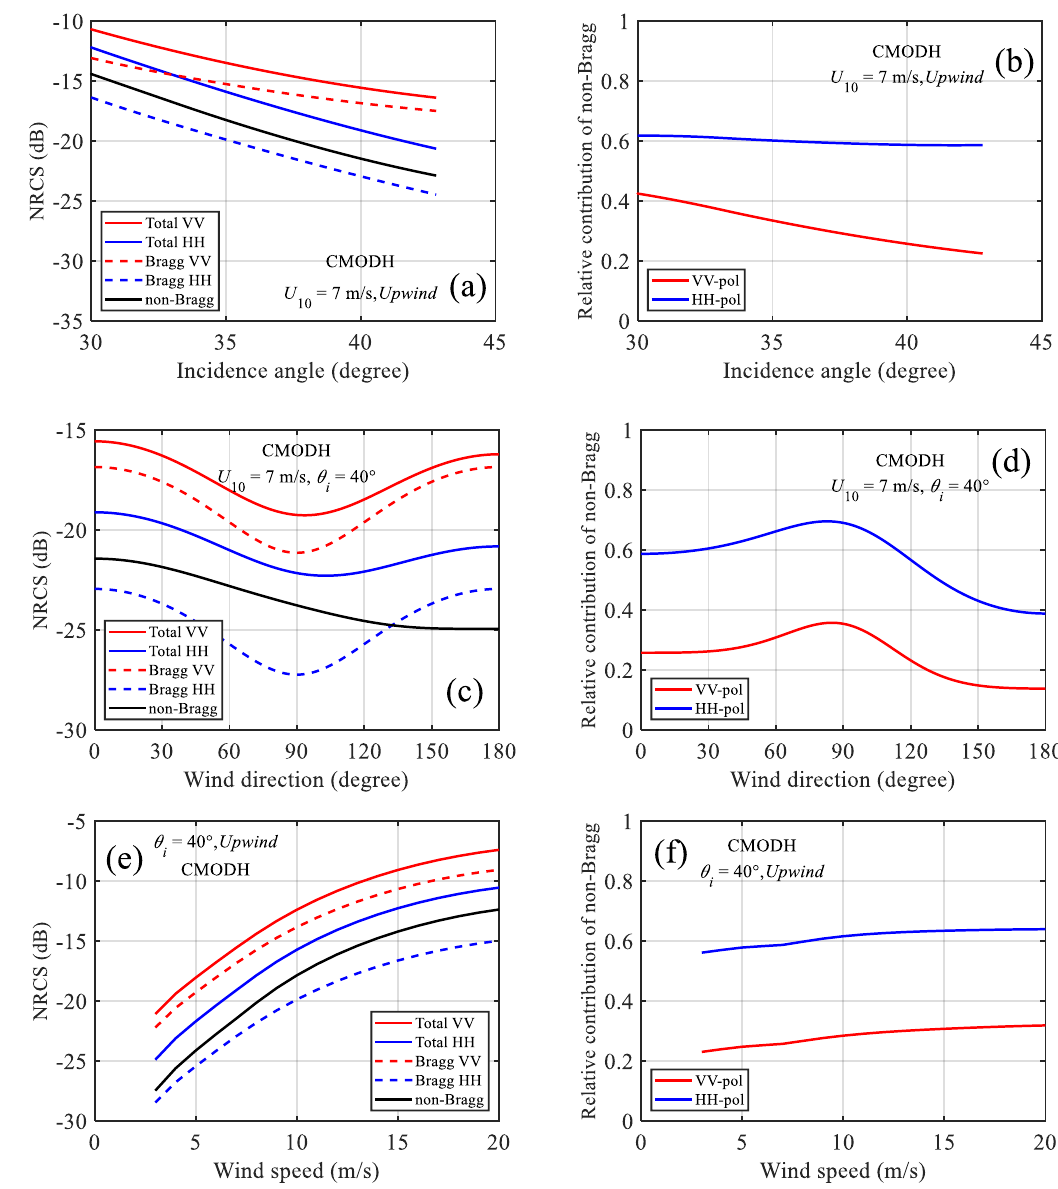
Figure 3. The NRCSs of total scattering, “pure” Bragg wave scattering and non-Bragg scattering, and the relative contribution of non-Bragg scattering estimated by using the CMODH. ( a , b ): with respect to incidence angles, ( c , d ): with respect to wind directions, ( e,f ): with respect to wind speeds.